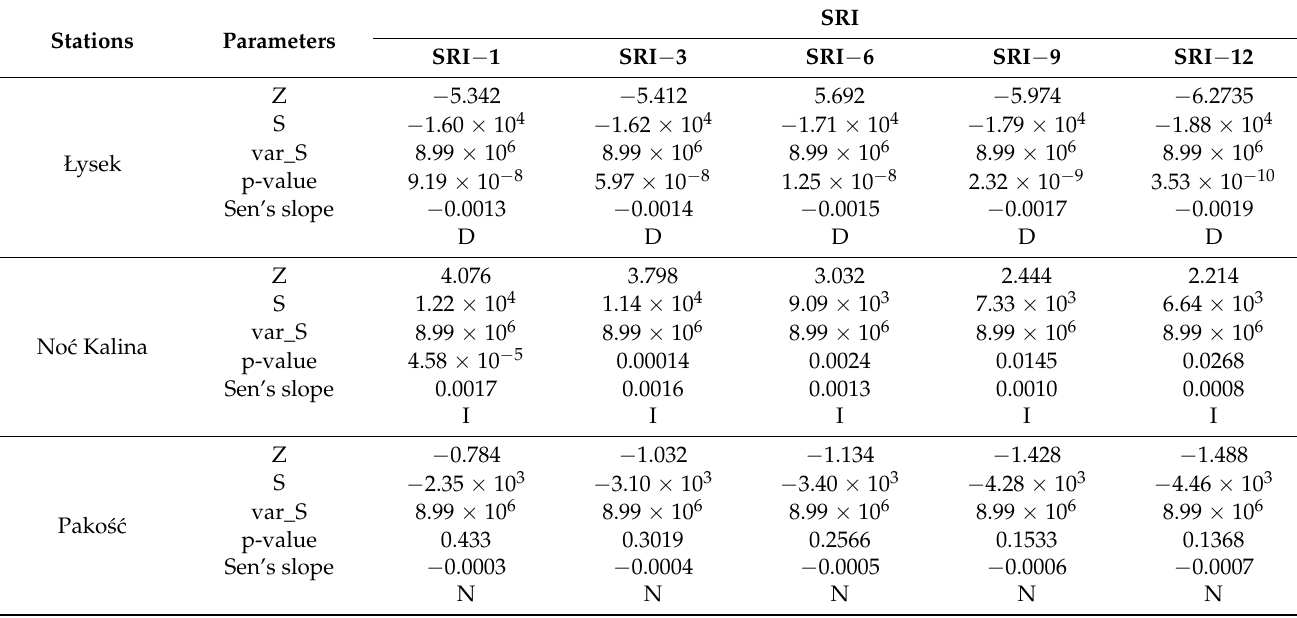
Table 7. Results of trend analysis SRI in different time scales in the period of 1981–2016 at hydrological stations.